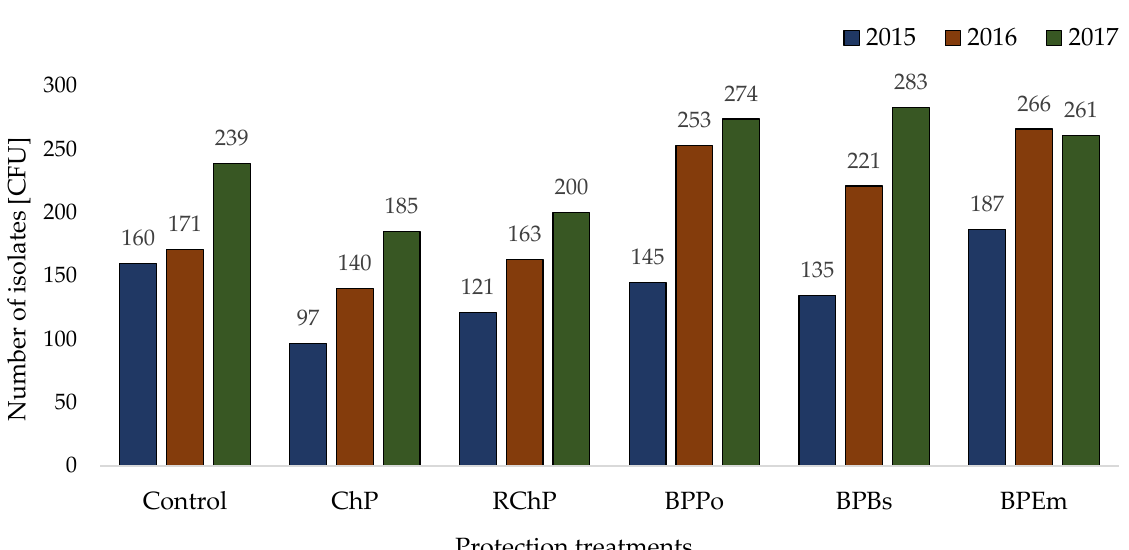
Figure 2. Number of colony forming units (CFUs) isolated from internally infected horseradish roots. It was shown that in the plots where seedlings were treated with PGP ( E. maxima )